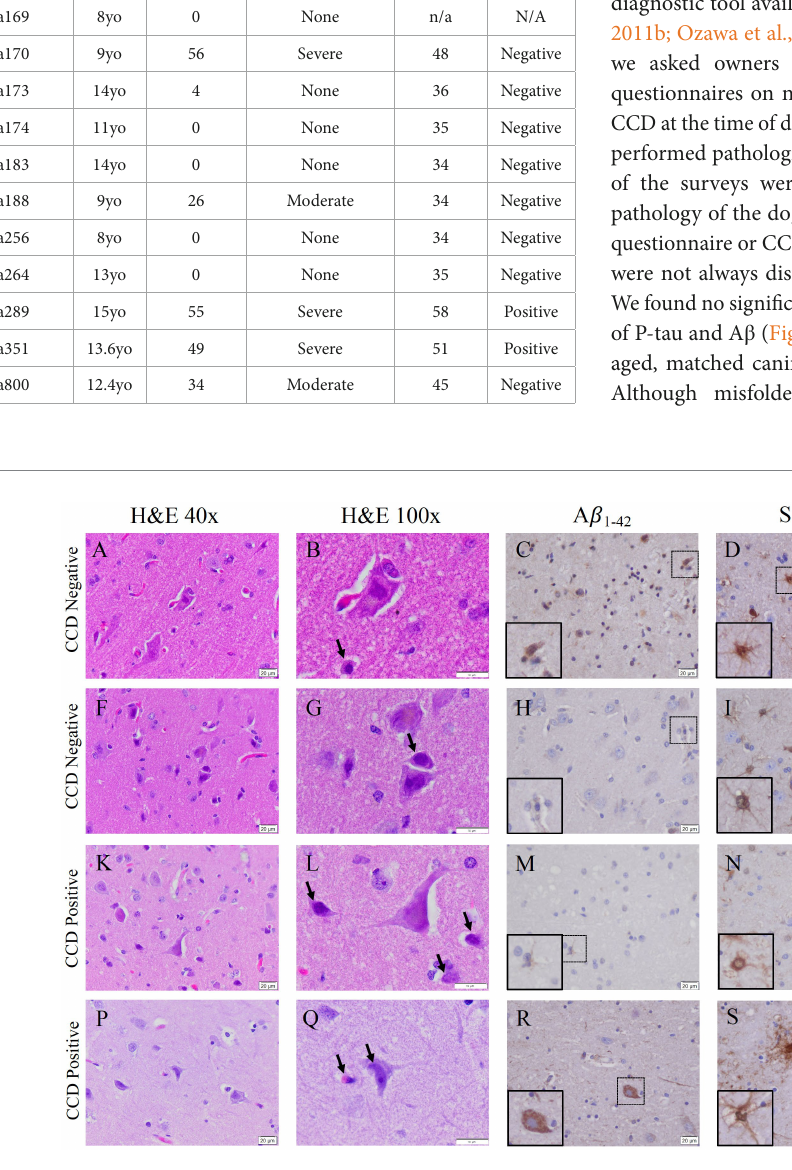
FIGURE 6 Gliosis and accumulation of misfolded proteins correlates to canines with positive cognitive dysfunction scores. (A) Aged canines with a CCDR/CADES score of being negative for CCD (A–J) does show an increase in gliosis and A β 1-42 accumulation but no P-tau at T-217. (B) Aged canines with a moderate or severe CCD score (K–T) show gliosis and A β 1-42 and P-tau positive cells. Canines negative or mild CADES n = 7; canines moderate or severe CADES n = 6. Scale bar = 20 μ M.